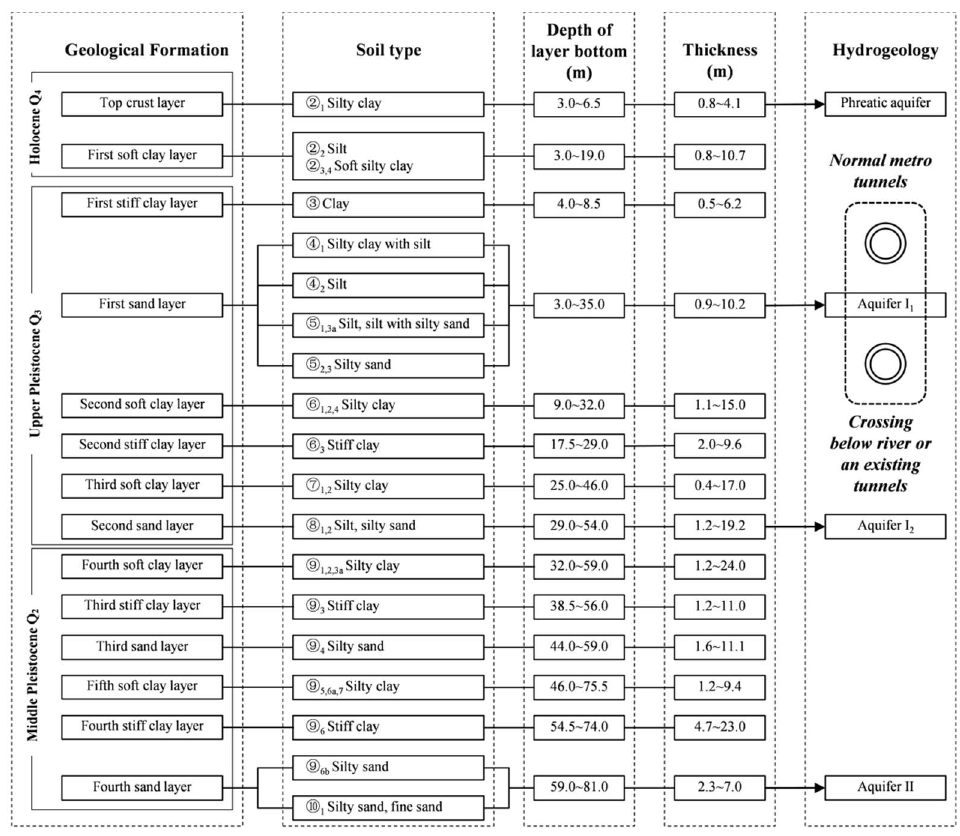
Figure 1. Location and distribution of the rail track system in Changzhou.